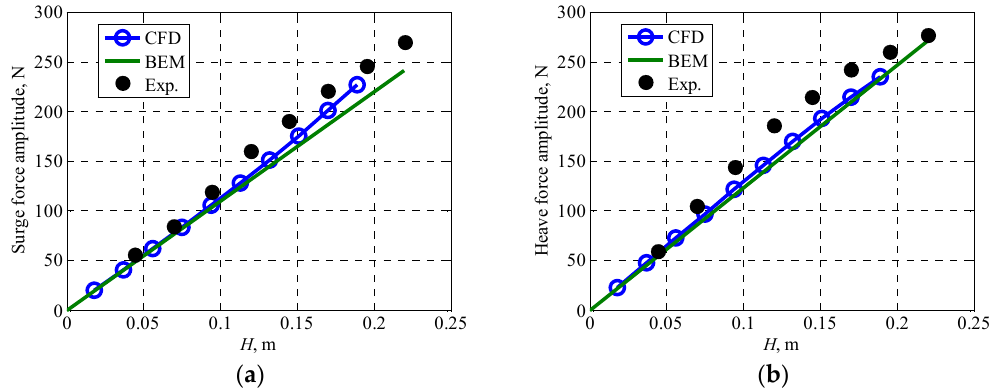
Figure 9. Comparison of the hydrodynamic force amplitude as a function of wave height at T = 1.6 s: ( a ) surge force; ( b ) heave force.